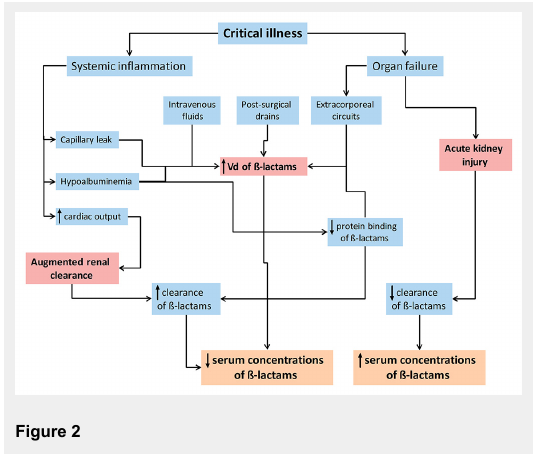
Pathophysiological alterations in critically-ill patients and their predicted influence on β-lactam pharmacokinetics. Vd = volume of